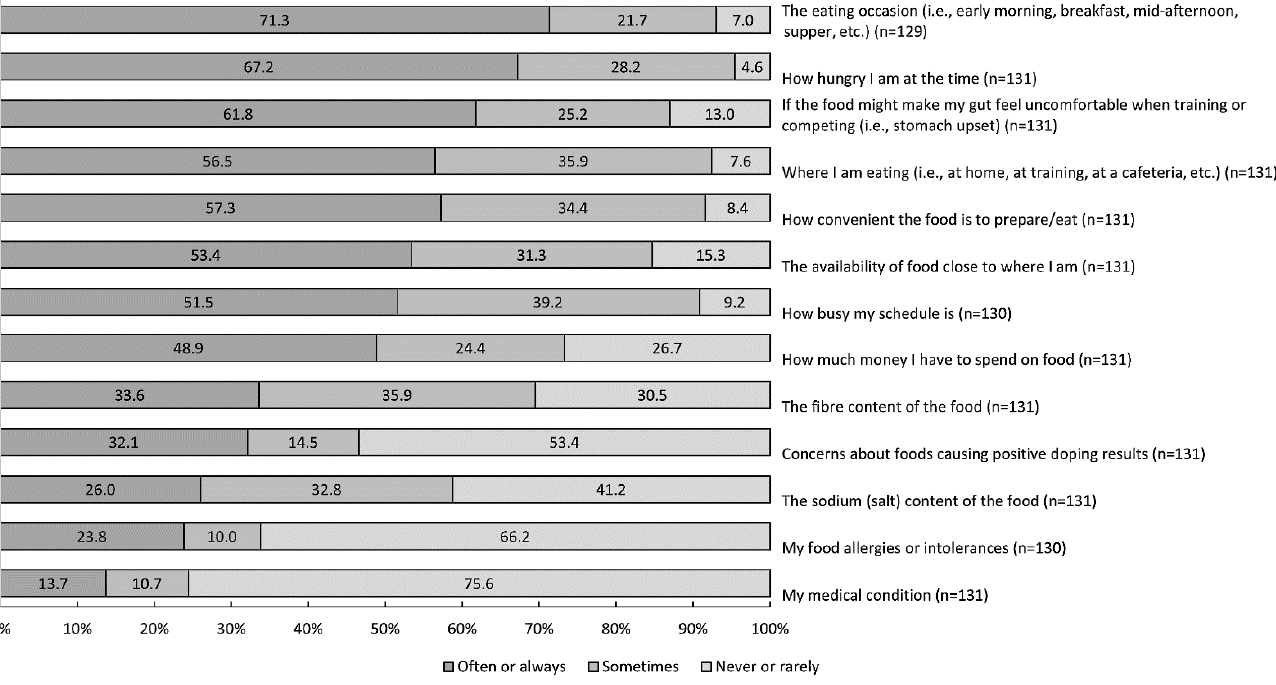
Figure 1. The proportion of 131 athletes rating how frequently (never/rarely, sometimes, and often/always) 13 individual items influence their food choices.